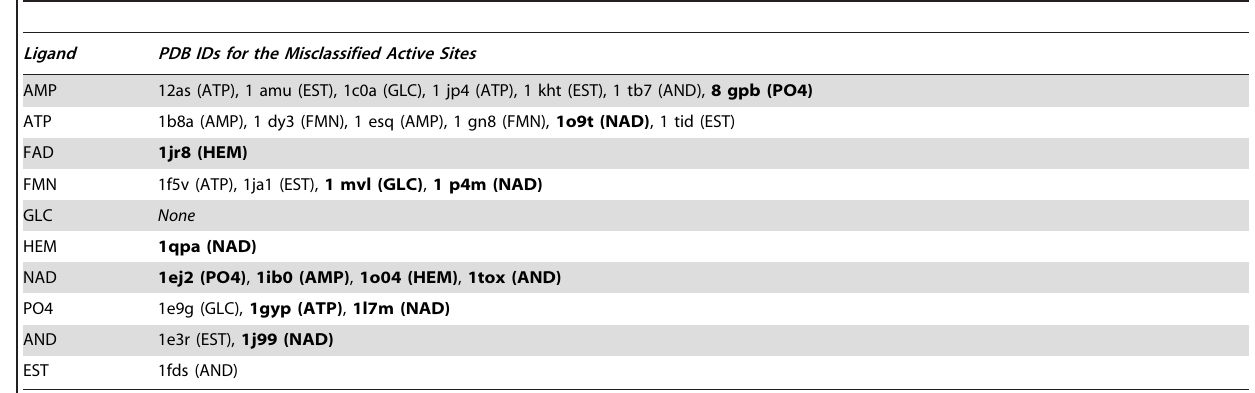
Table 7. The misclassified binding sites (classified ligands in